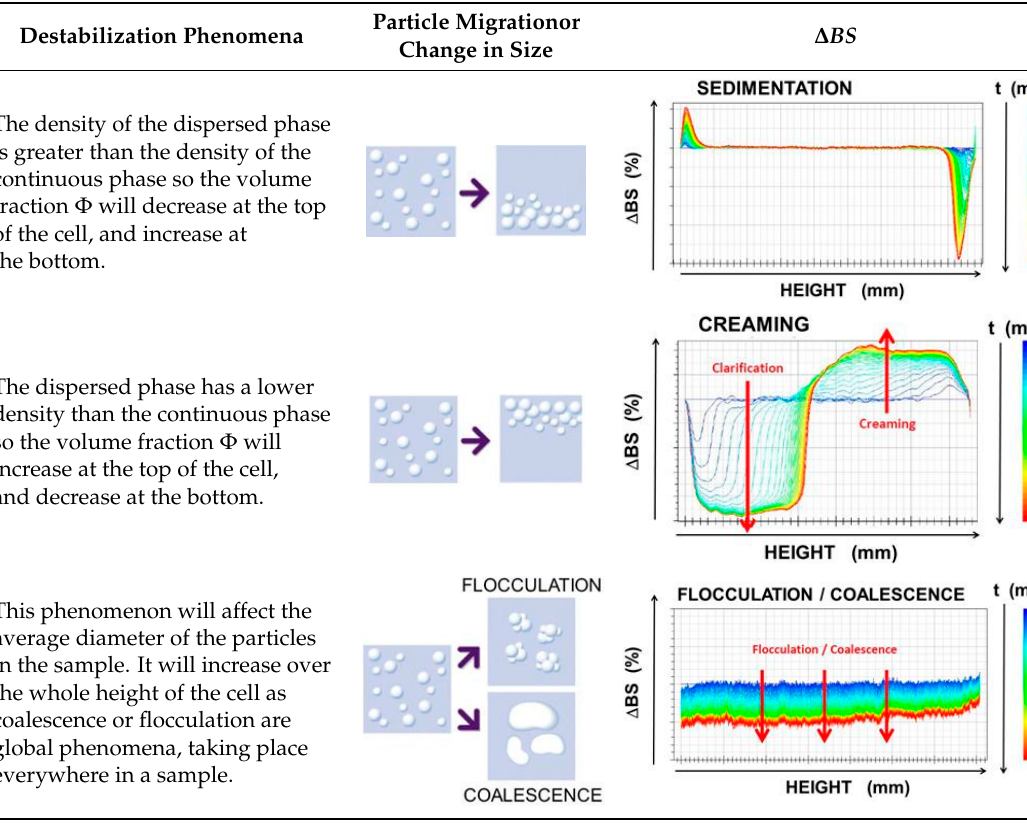
Table 3. Destabilization phenomena occurring in inhomogeneous dispersions and the ∆ BS analysis carried out by Turbiscan instrument [17]. BS : backscattering.